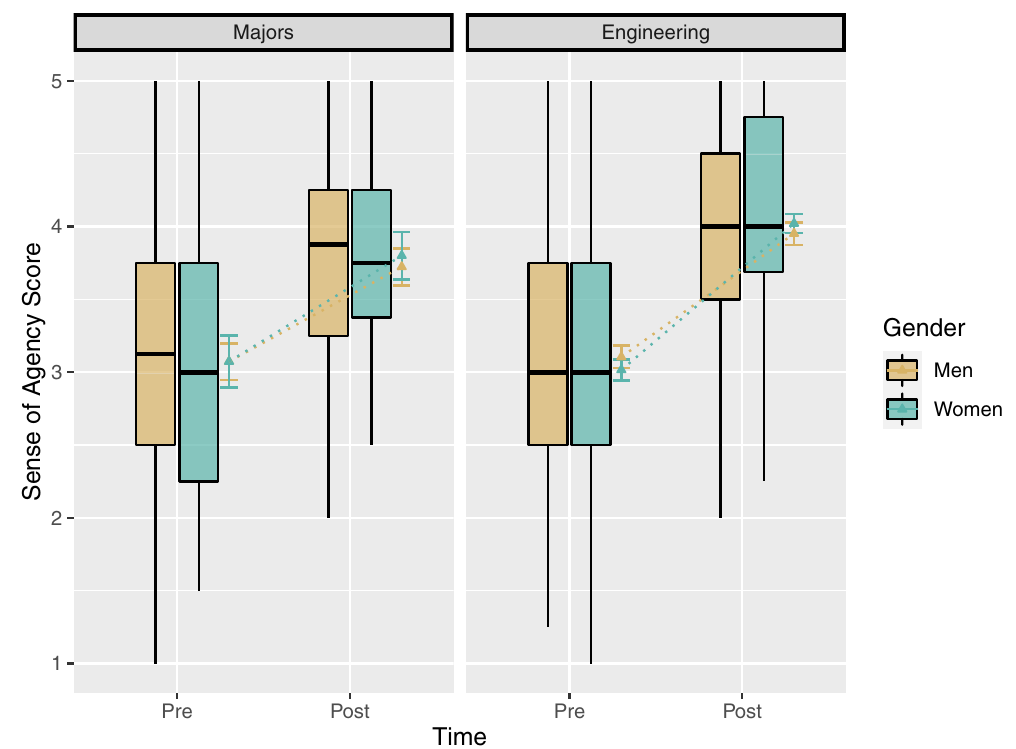
FIG. 2. Raincloud plot [62] presents the shift in students ’ sense of agency scores from pre- to post-test by gender in two physics courses with the same lab curricula. The box plot indicates the median, interquartile range, and the full range of scores. The figure also includes the mean and standard errors, with dotted lines indicating the shift in the mean sense of agency by